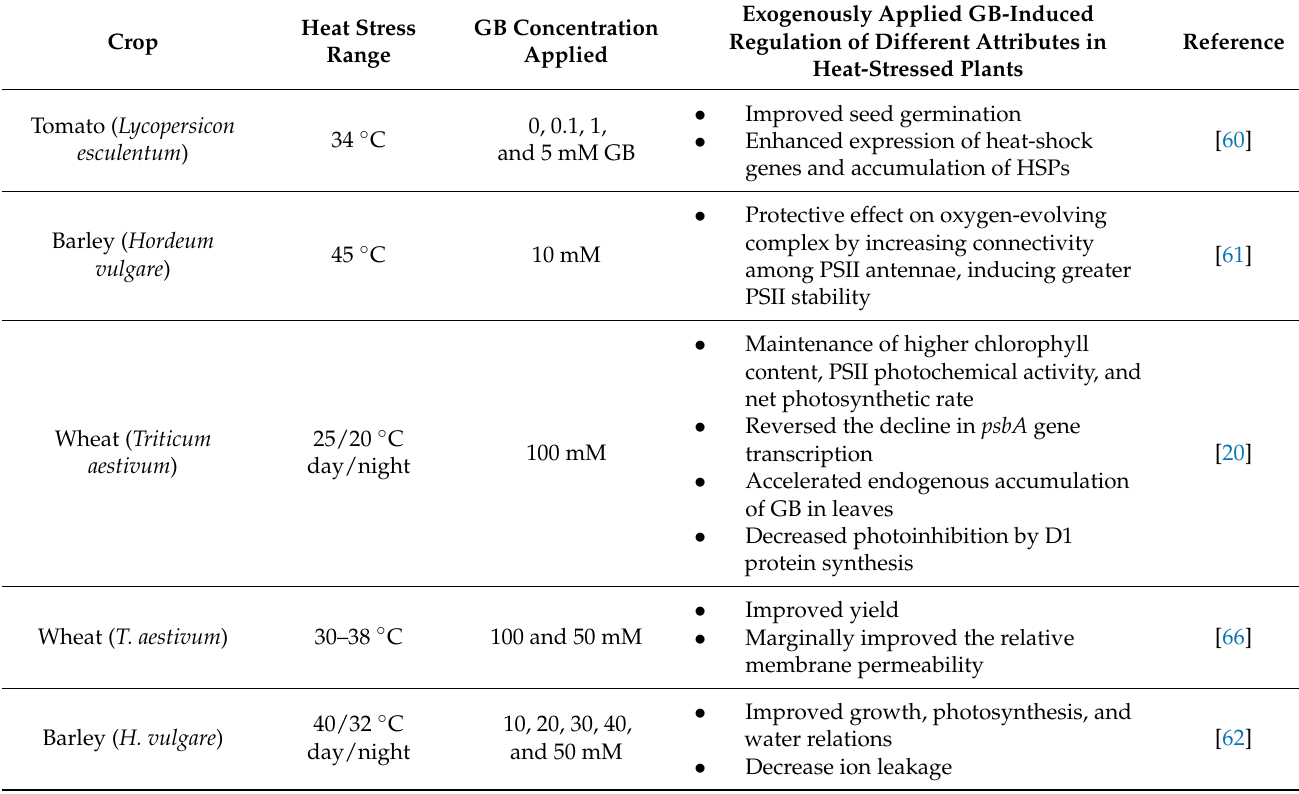
Table 2. Effect of exogenously applied GB on the regulation of different physio-biochemical attributes in heat-stressed